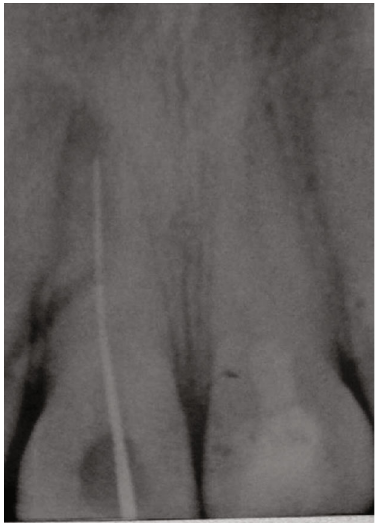
Figure 7: 24-month follow-up radiograph of 11: an apical barrier was formed easily crossable with a fi le.